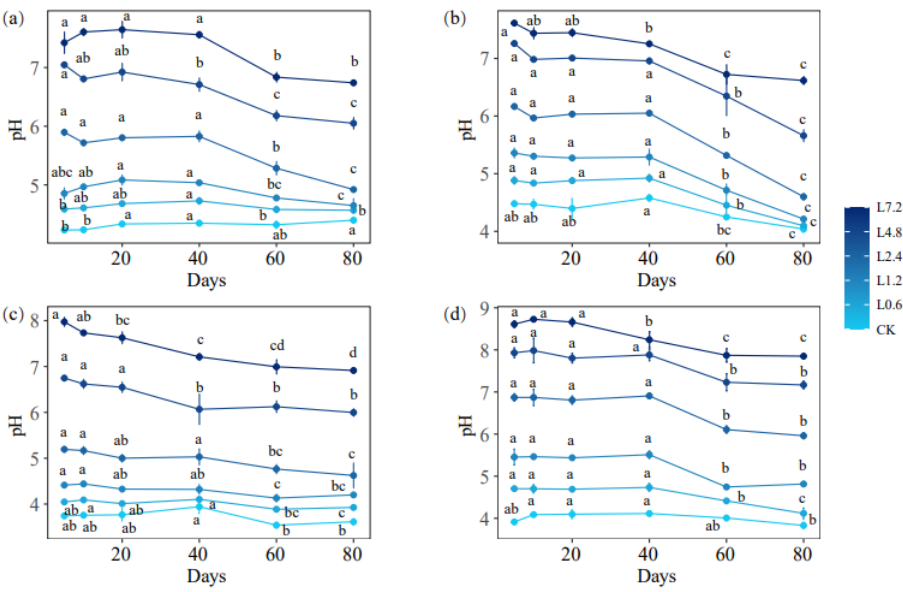
Figure 1. Dynamics of the pH of soils ( a – d ). Different lowercase letters represent significant differ- ences between different incubation times for the same treatment ( p < 0.05).